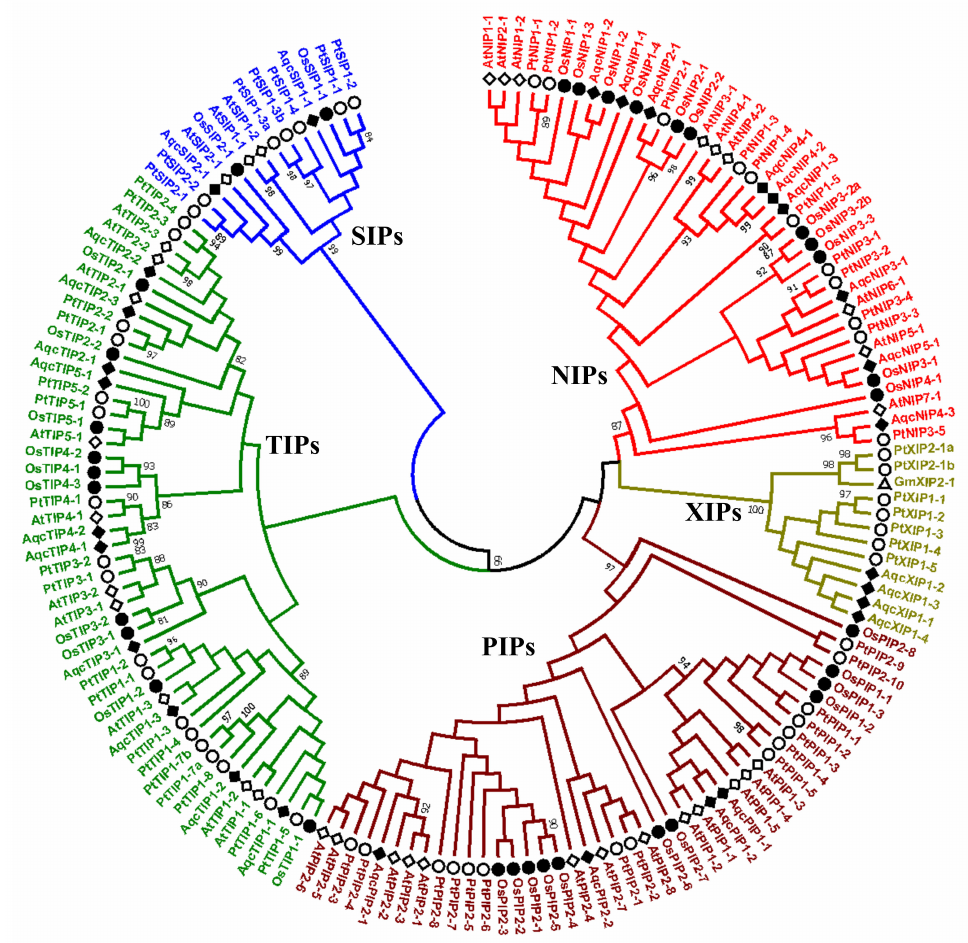
Figure 1. Phylogenetic analysis of aquaporins (AQPs) identified in the Aquilegia coerulea genome along with AQPs previously identified in rice, Arabidopsis and poplar genomes. Phylogenetic tree showing distribution of AQPs in five di ff erent subfamilies, namely, NOD26-like intrinsic proteins (NIPs; red), tonoplast intrinsic proteins (TIPs; green), plasma membrane intrinsic proteins (PIPs; maroon), small basic intrinsic proteins (SIPs; blue) and uncharacterized intrinsic proteins (XIPs; gold). The genes from Arabidopsis, rice, poplar, soybean and Aquilegia are indicated with the prefixes At ( Arabidopsis thaliana , hollow square), Os ( Oryza sativa , filled circle), Pt ( Populus trichocarpa , hollow circle), Gm ( Glycine max ) XIPs (hollow triangle) and Aqc ( Aquilegia coerulea , filled square),